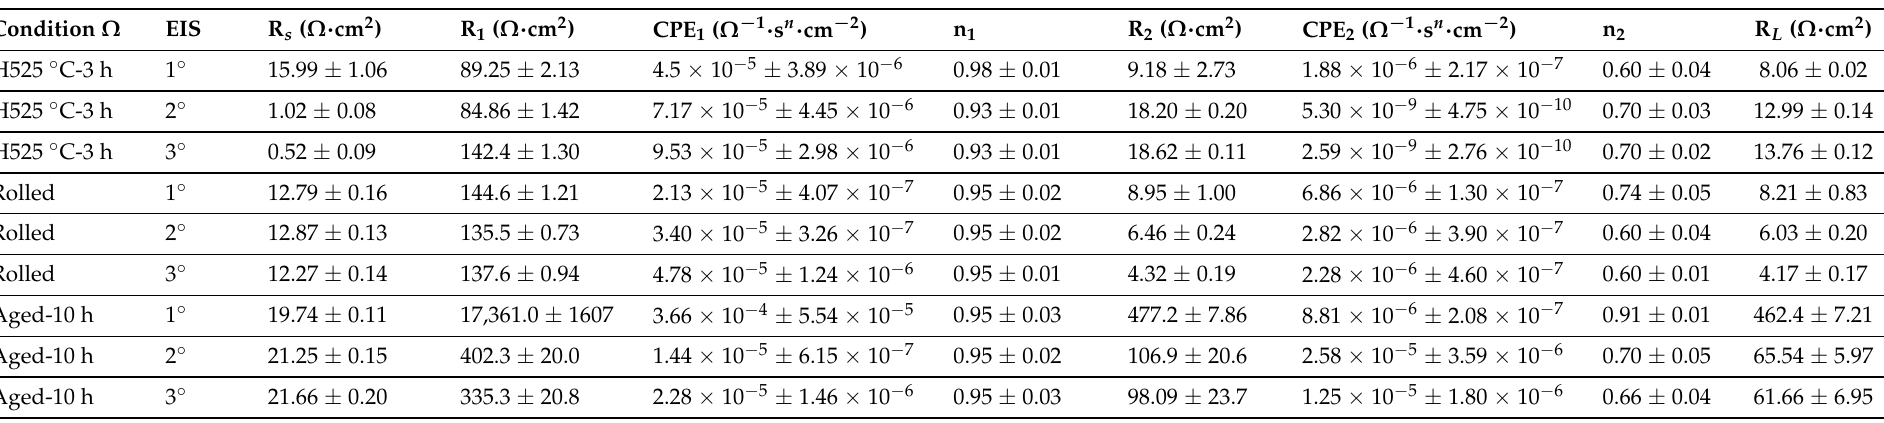
Table 3. Fit of the equivalent circuit parameters of H525 ◦ C-3 h, rolled and aged-10 h